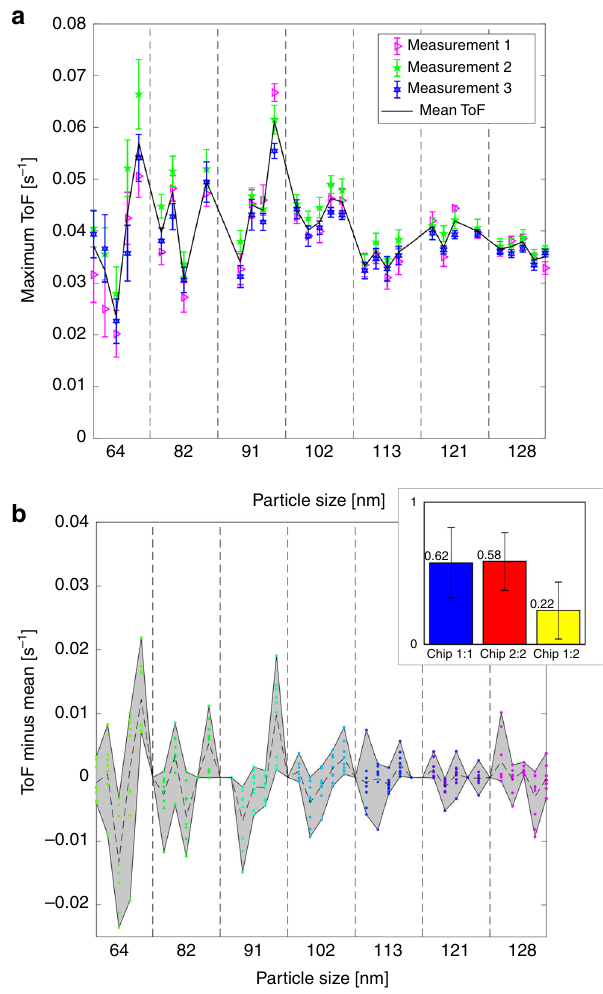
Fig. 5 Particle-speci fi c ToFs obtained in multiple experiments. a Three separate measurements executed with an initial incoming fl uorescein concentration of 4.6 µ M and constant sodium borohydride concentration of 50 mM. The error bars display the standard deviation for 10 values of the ToF measured at the nominal fl uorescein concentration at the beginning of the experiment. Note that the same particles exhibit the highest/lowest activities in all experiments. b ToF with the subtracted mean value for each particle obtained from a total of nine independent experiments (such as the ones displayed in Fig. 3 and Supplementary Figs. 19 – 21) carried out on the same sample (chip 1). The colored dots (of same color code as in the previous fi gures) indicate the speci fi c values of ToF with subtracted mean obtained for each particle in each measurement, the gray area depicts the span between the highest and lowest values and the dotted line corresponds to the mean value of each particle for all nine measurements. The inset displays the correlation coef fi cients between all ToFs with subtracted mean values for all measurements on two different but nominally identical samples, chip 1 & chip 2. In blue: only measurements from chip 1, in red: only measurements from chip 2, and in yellow: measurements in chip 1 correlated with measurements in chip 2. Error bars in the inset display standard